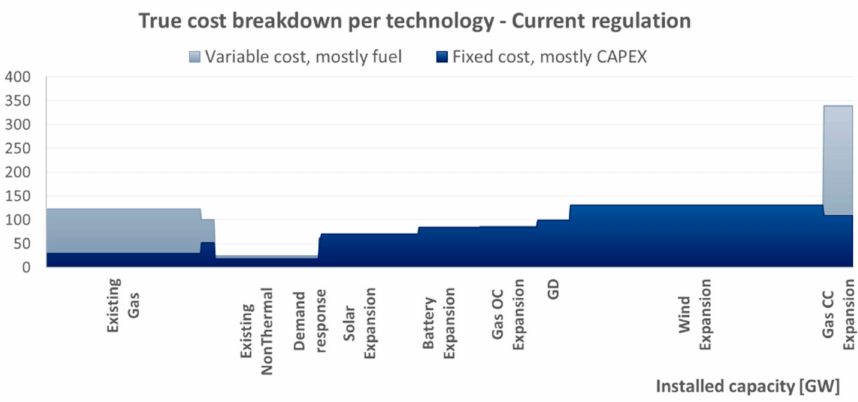
Figure 22. Cost breakdown in the current regulation scenario. Total cost (variable + fixed) equal to USD 25.3